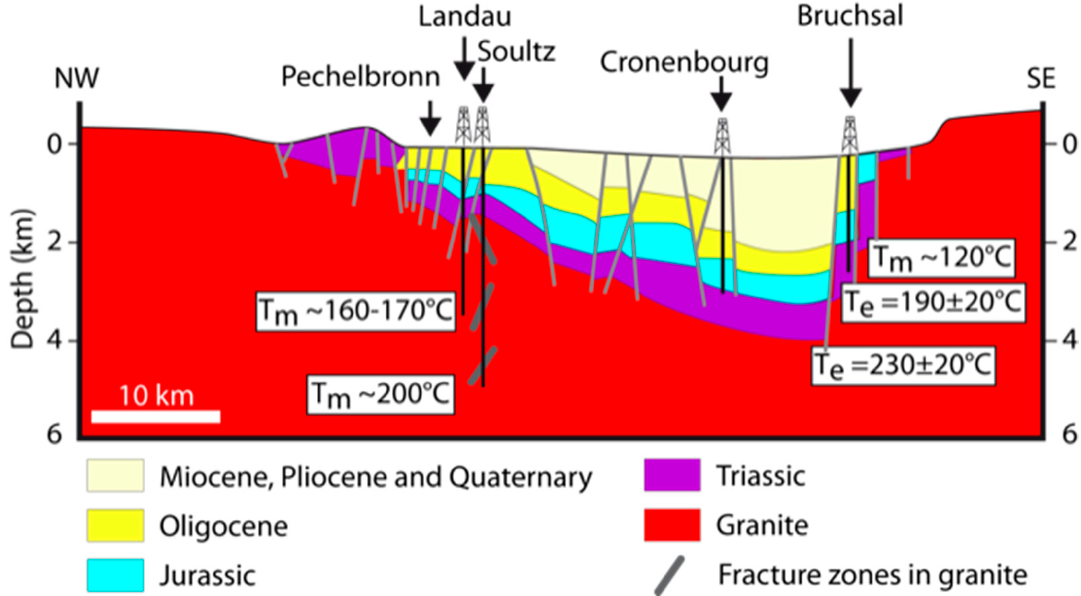
Figure 1. Cross-section of the Upper Rhine Graben (URG) modified after [12]. The temperatures were measured in drillholes (Tmeas.) or estimated from geothermometers (T est.), with their values indicated at the depth at which they were measured or estimated.